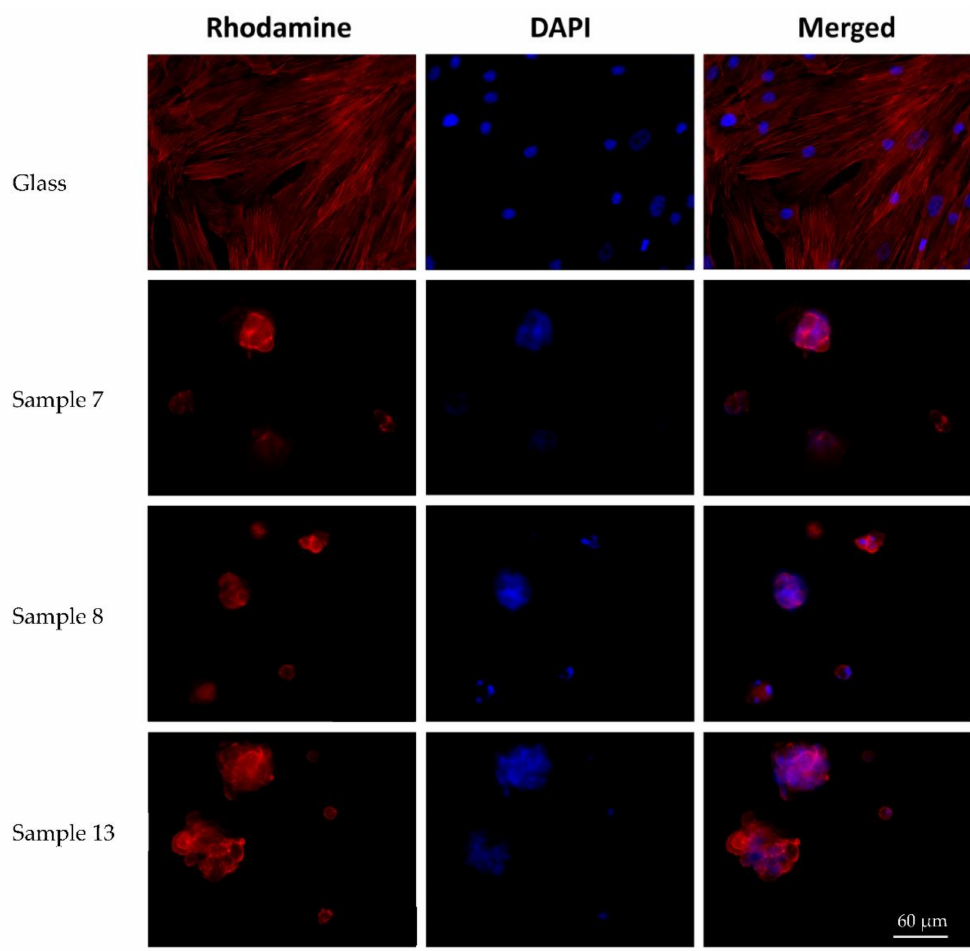
Figure 7. Spheroids on the surface of the cryogel samples (magnification of ×